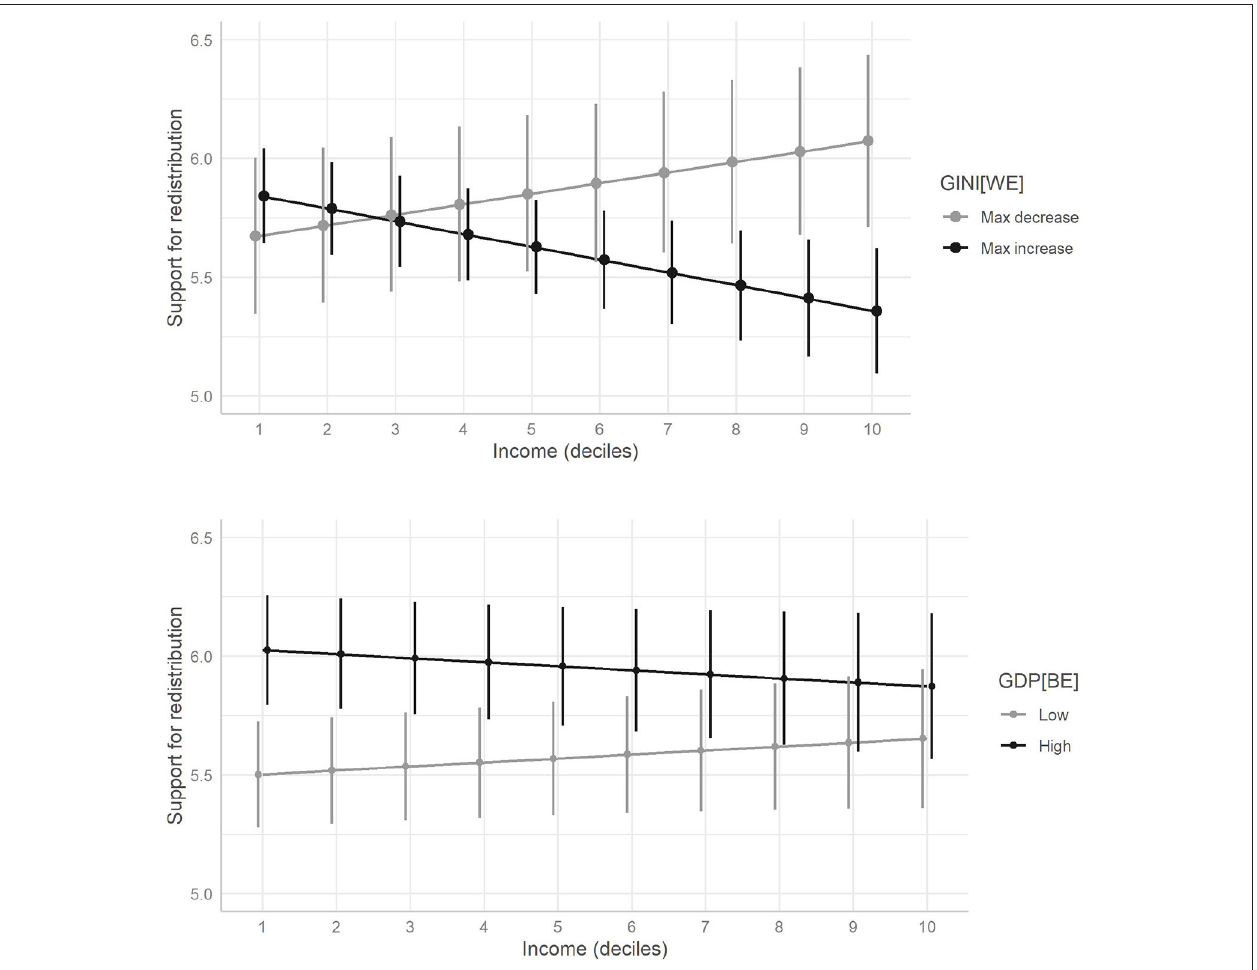
FIGURE 7 | Predicted values of support for redistribution as a function of income deciles with different inequality changes (GINI[WE]) and economic development levels (GDP[BE]). Dots show predicted values; bars represent 95% confidence